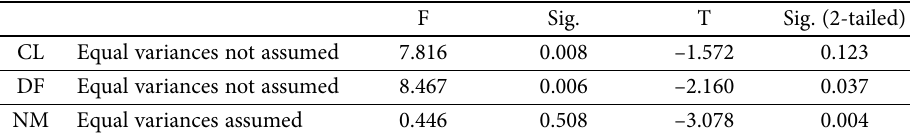
Table 5. Student’s independent t-tests of enterprise performance measures between “High AU” and “Low AU” groups of ISDM elements F Sig. T Sig. (2-tailed) CL Equal variances not assumed 7.816 0.008 –1.572 0.123 DF Equal variances not assumed 8.467 0.006 –2.160 0.037 NM Equal variances assumed 0.446 0.508 –3.078